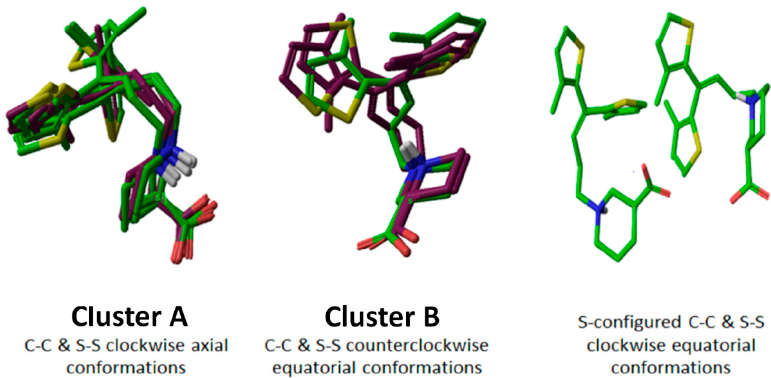
Figure 2. ( A – D ) R- (maroon) and ( E – H ) S- (green) configured –NH group of tiagabine enantiomers further classified on the basis of different orientations of thiophene rings and –COOH group.